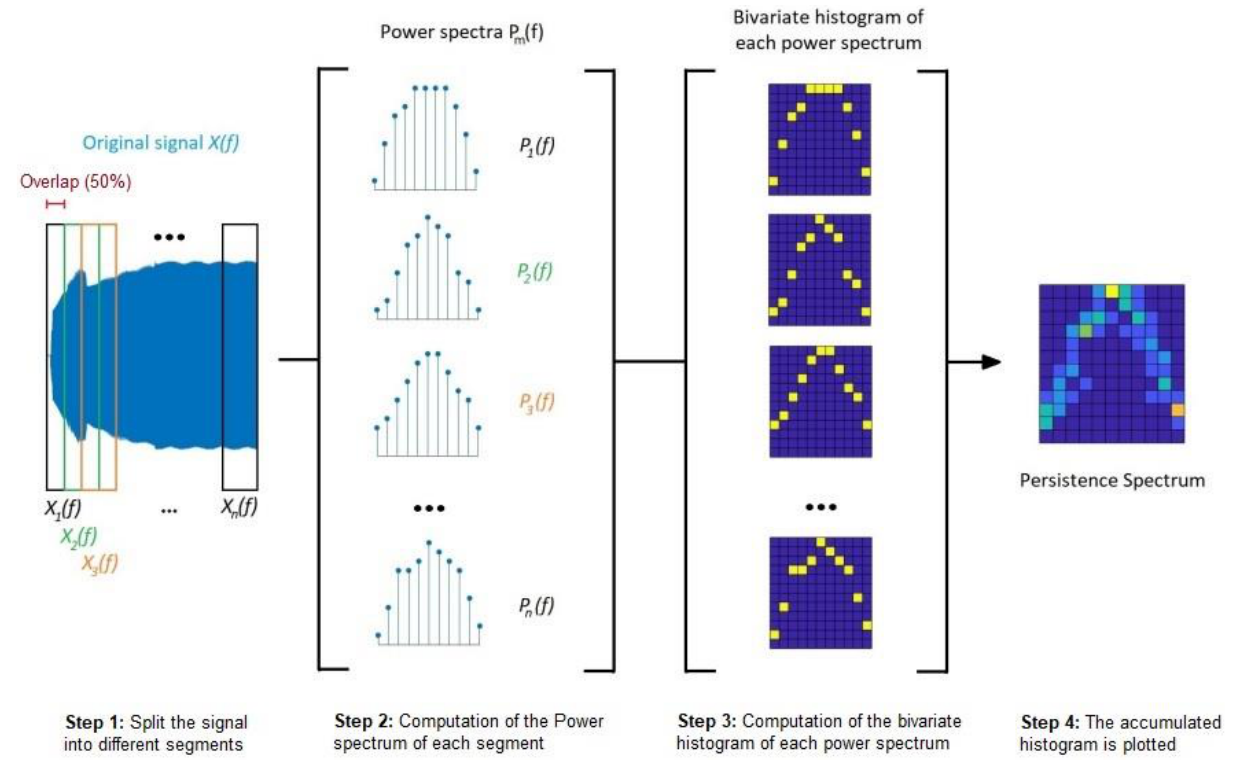
Figure 3. Overview of the Persistence Spectrum computation procedure. Step 1: Split the signal into different segments. Step 2: Computation of the power spectrum of each segment. Step 3: Computation of the bivariate histogram for each power spectrum. Step 4: The accumulated histogram is plotted.